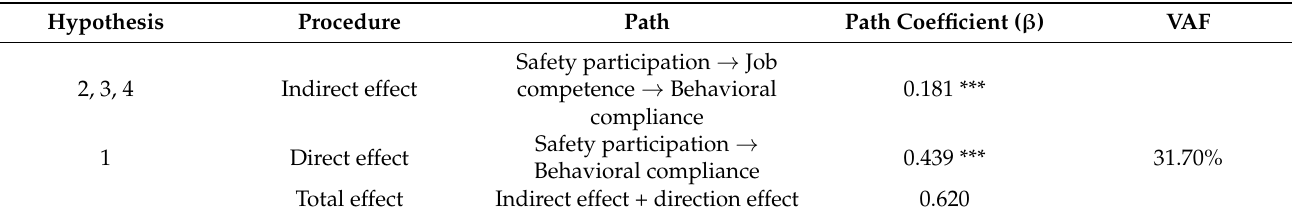
Table 7. Analysis of the mediating effect of job